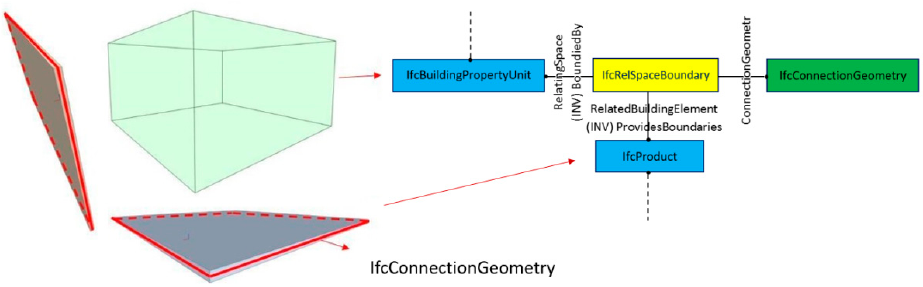
Figure 5. The illustration of the BoundedBy attribute for the new IfcBuildingPropertyUnit